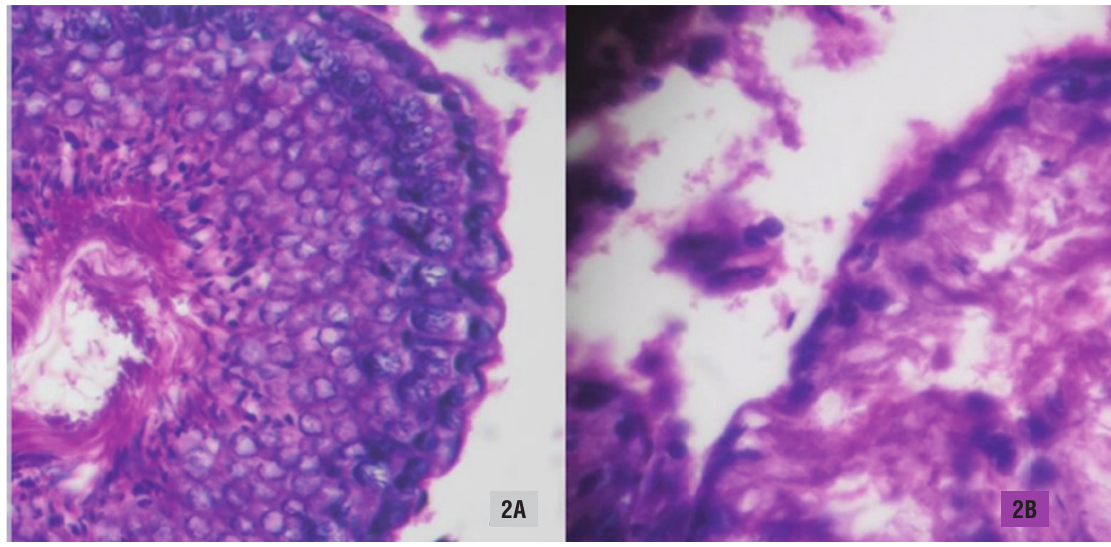
Figure 2 - histological analysis of an orchiectomy specimen 15 days after orchidopexy in an experimental rat model. A) normal histology; B) Impaired